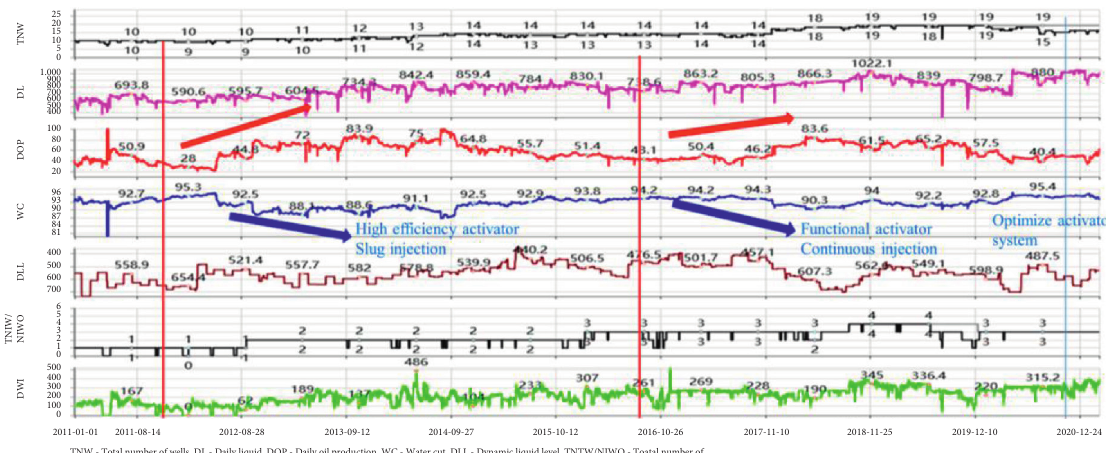
Figure 13: Oil recovery curve for microbial flooding in the Zhan 3 block in the Shengli